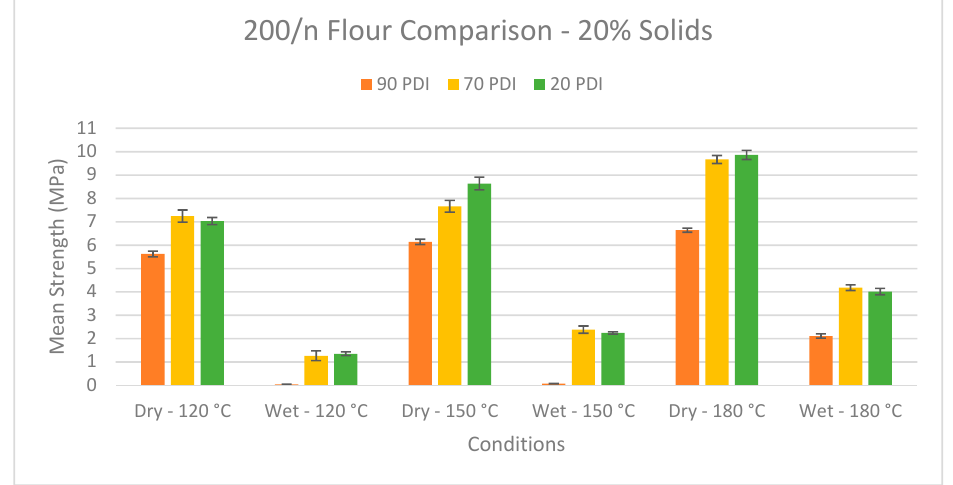
Figure 1. Shear strengths of soy flour adhesives with maple veneer bonded at different temperatures and tested dry and wet.